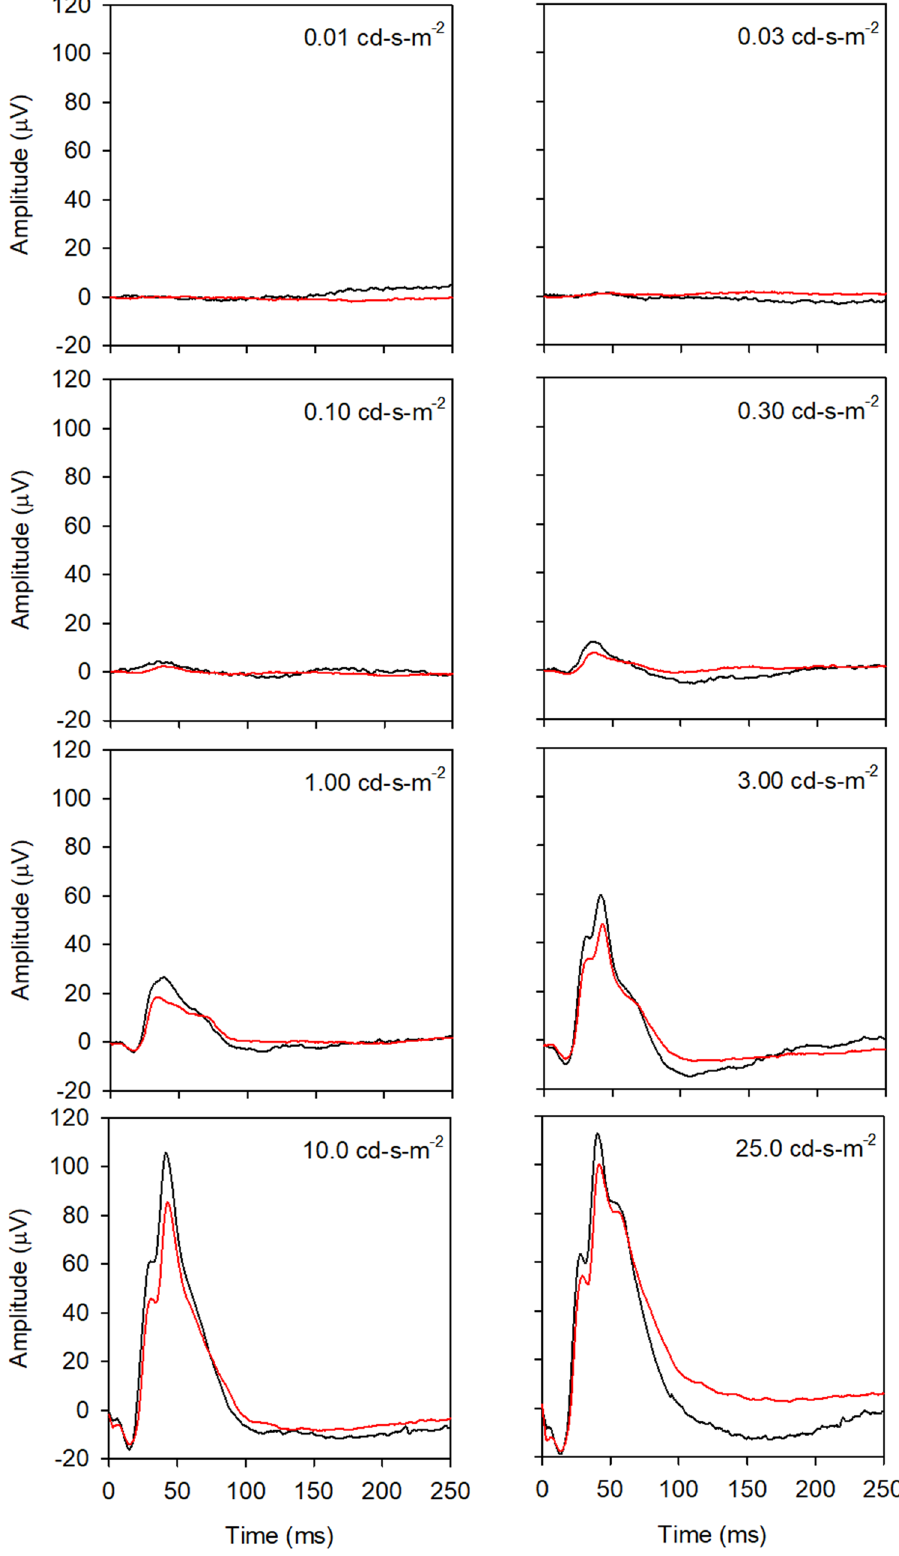
Figure 4. Mean waveforms for the WT (black) and 5xFAD (red) mice are shown for the 8 different flash luminances (indicated in each panel) under light-adapted